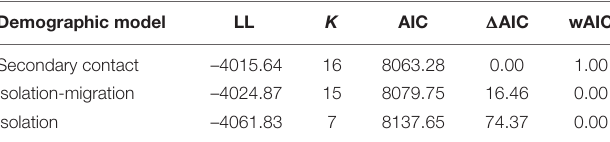
TABLE 2 | Demographic model selection results for the north, south and west populations of Phrynosoma hernandesi . Demographic model